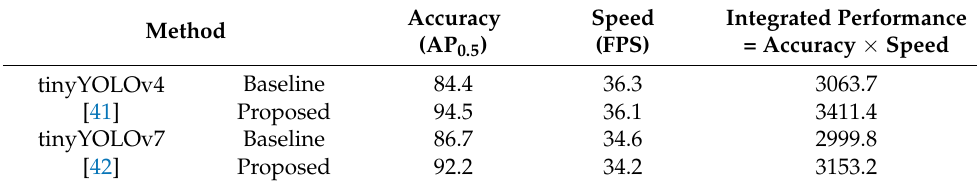
Table 8. Comparison of average performance for Hadong pig pen on a TX-2